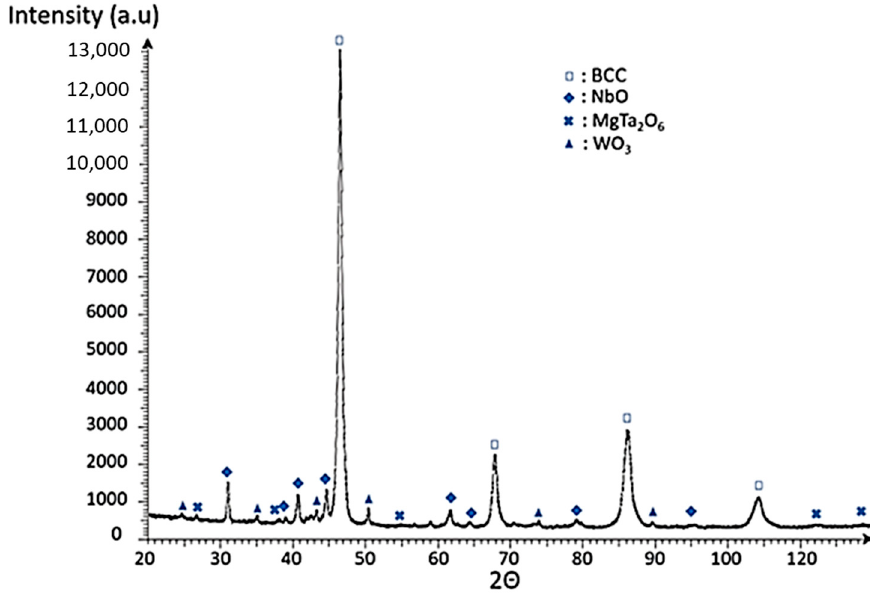
Figure 5. Sintering curves of milled and unmilled WMoTaNb powder.